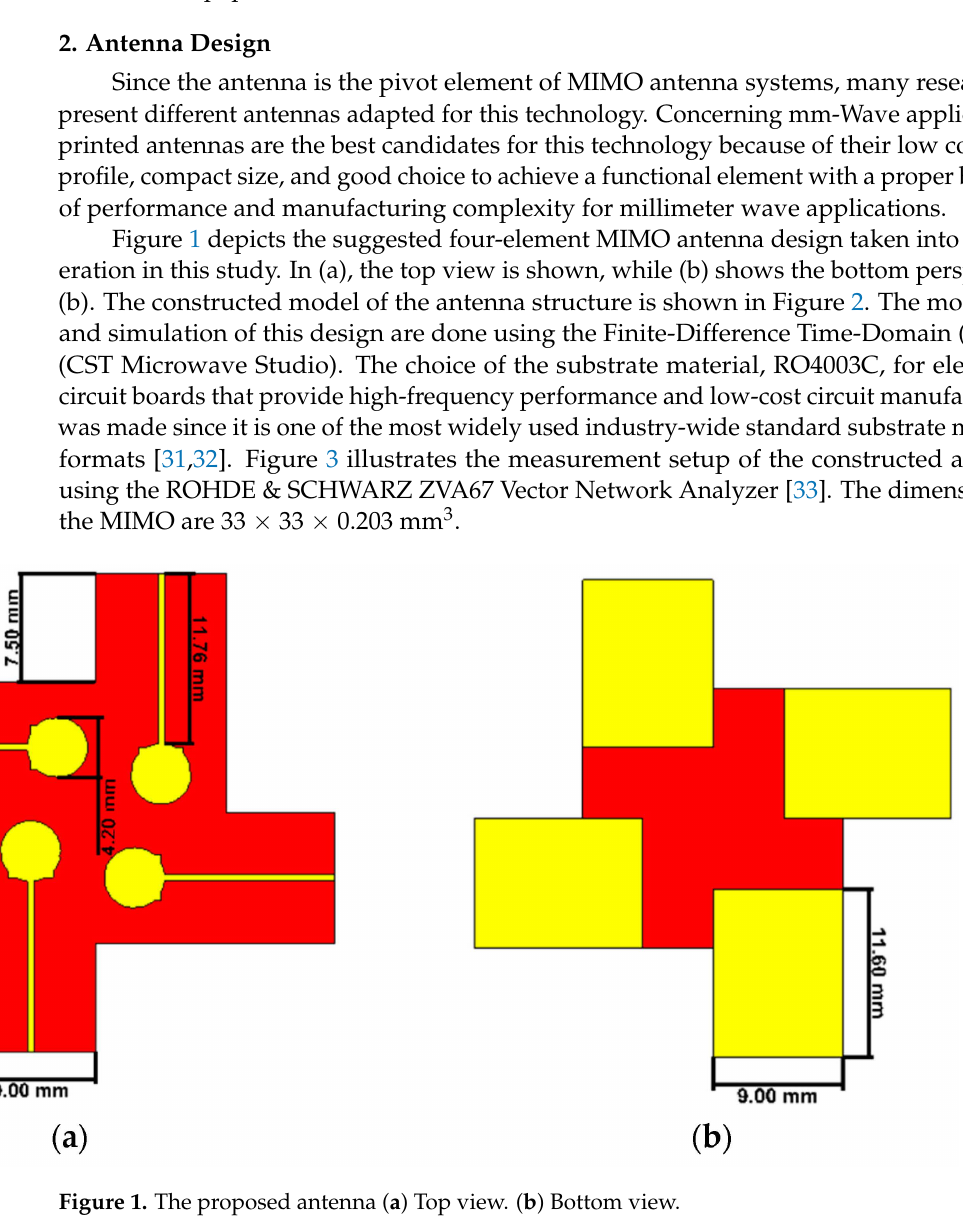
Figure 1. The proposed antenna ( a ) Top view. ( b ) Bottom